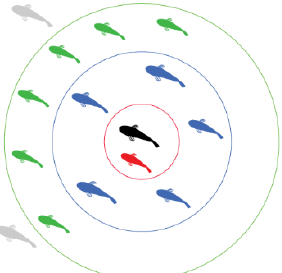
Figure 3. Zonal model of collective movements based on the basic SPP model; modified from Brace et al. (2016) and Garland et al. (2018)